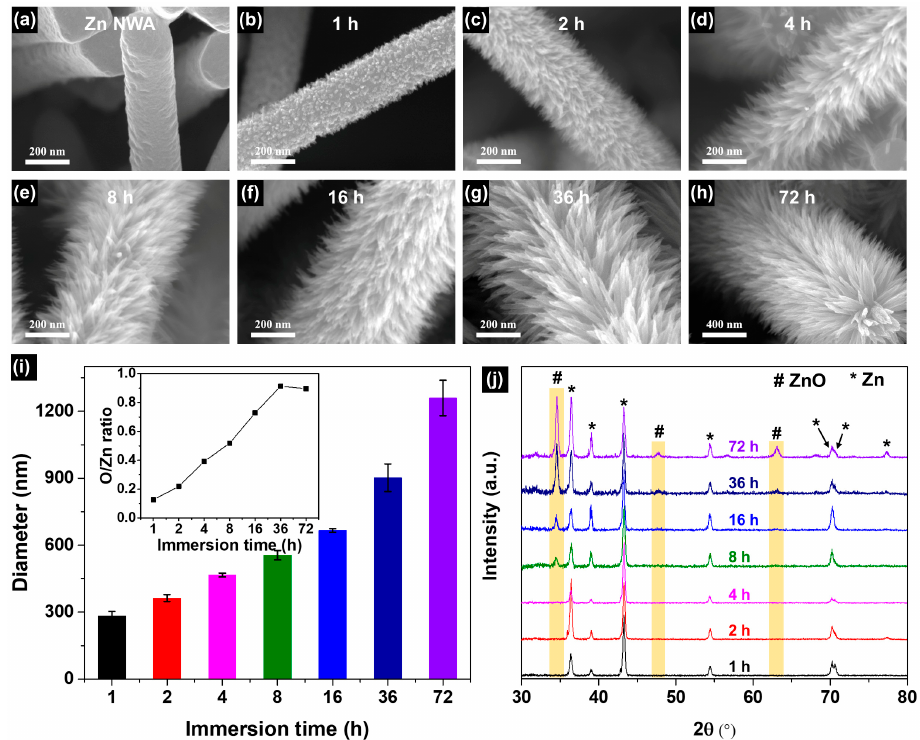
Figure 4. SEM images of ( a ) Zn NWA and B-ZnO NWA prepared in 0.08 M NaOH solution with an immersion time of ( b ) 1 h, ( c ) 2 h, ( d ) 4 h, ( e ) 8 h, ( f ) 16 h, ( g ) 36 h, and ( h ) 72 h. ( i ) Diameter of B-ZnO NW prepared with different immersion times. The corresponding O/Zn ratio of B-ZnO NWA is given as an inset. ( j ) XRD patterns of B-ZnO NWA prepared with different immersion times.